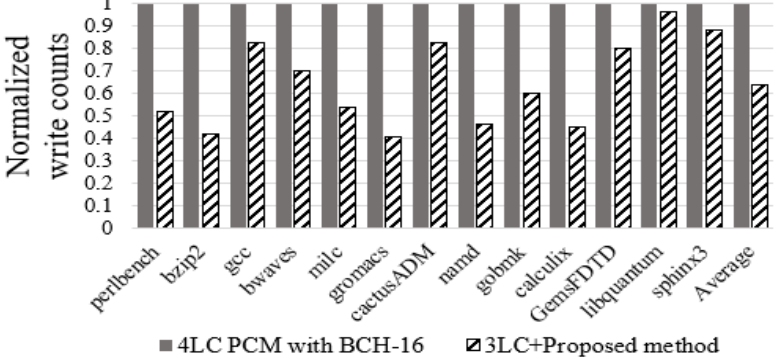
Figure 10. Comparison of lifetime between proposed method and 4LC PCM with an ECC.